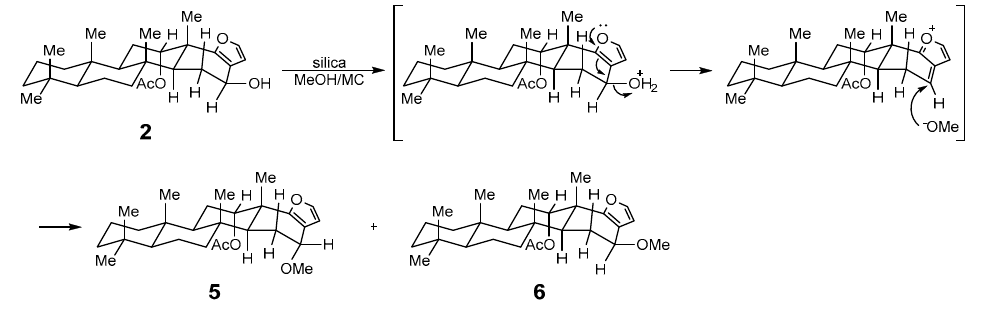
Figure 4. Chemical transformation of 2 into 5 and 6 .